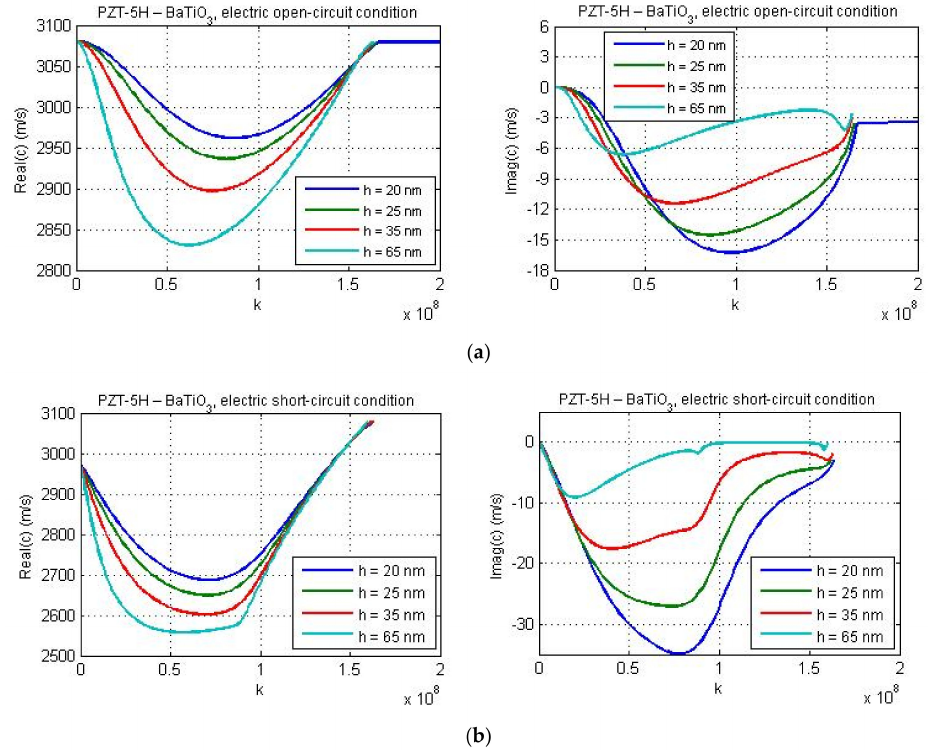
Figure 9. The effect of the guiding layer thickness on the real and imaginary parts of phase velocity for the data of materials PZT-5H—BaTiO 3 ; ( a ) electric open-circuit conditions and ( b ) electric short-circuit conditions.